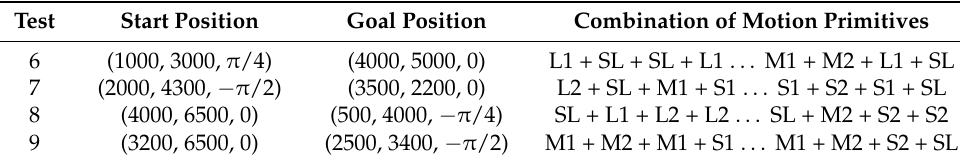
Table 5. Combination of motion primitives for Test 6-Test 9 motion planning paths.